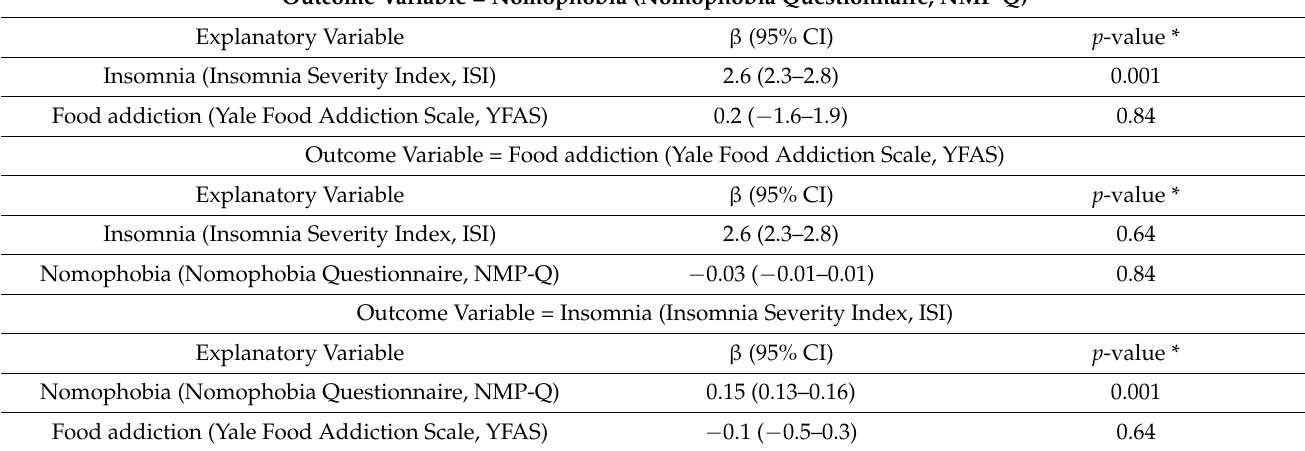
Table 3. Association between nomophobia (Nomophobia Questionnaire, NMP-Q score), insomnia (Insomnia Severity Index, ISI score), and food addiction (Yale Food Addiction Scale, YFAS